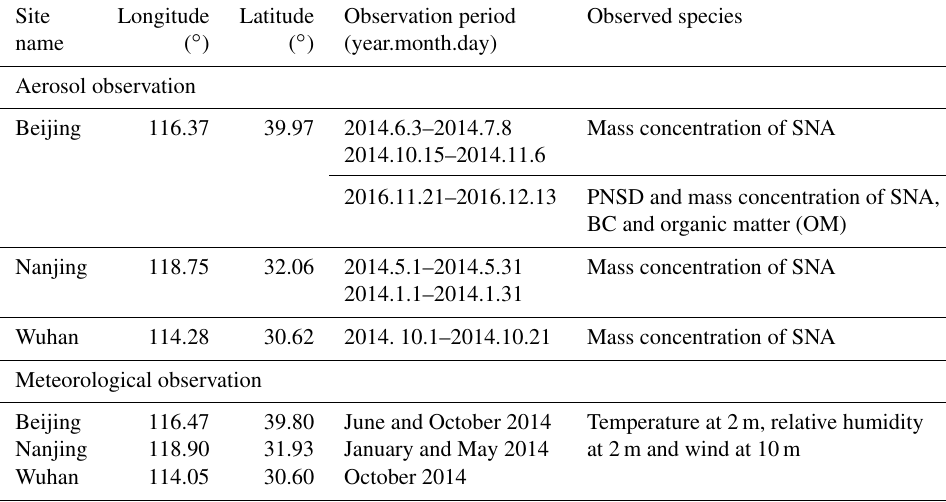
Table 2. Information of observations for aerosol components and particle number concentrations.